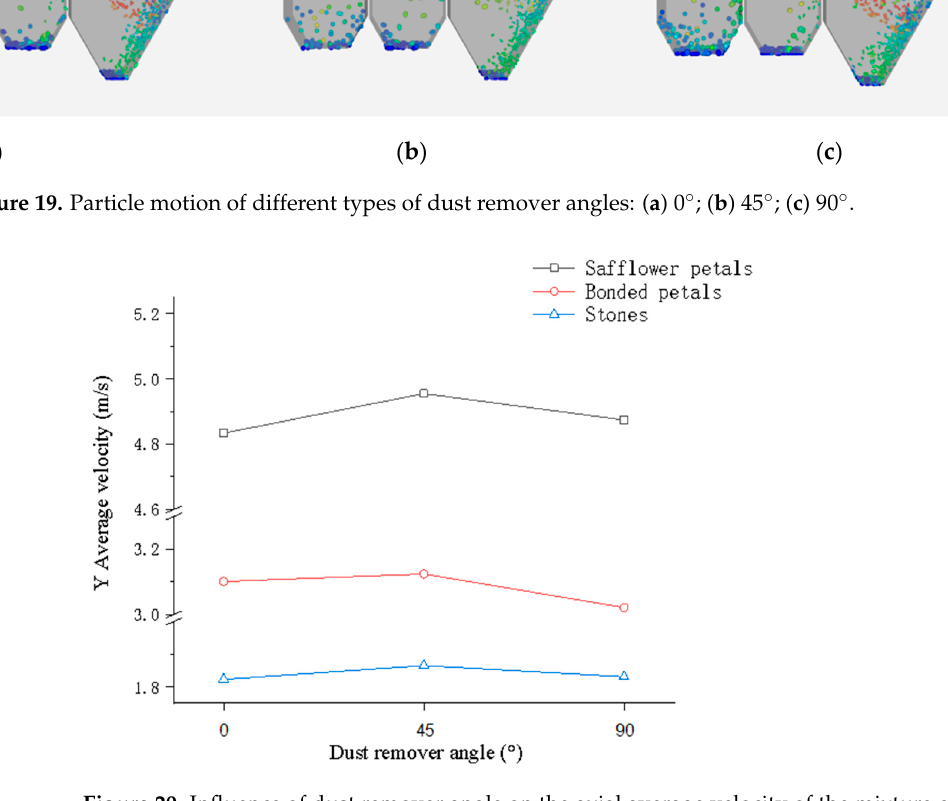
Figure 20. Influence of dust remover angle on the axial average velocity of the mixture components. 3.4. Simulation Trial Design and Analysis 3.4.1. Response Surface Method Test Scheme Single-factor simulation results and analysis were combined using the three-factor three-level Box–Behnken experimental design principle, with the inlet airflow velocity X1, airflow inclination angle X2 and dust remover angle X3 as independent variables, and the